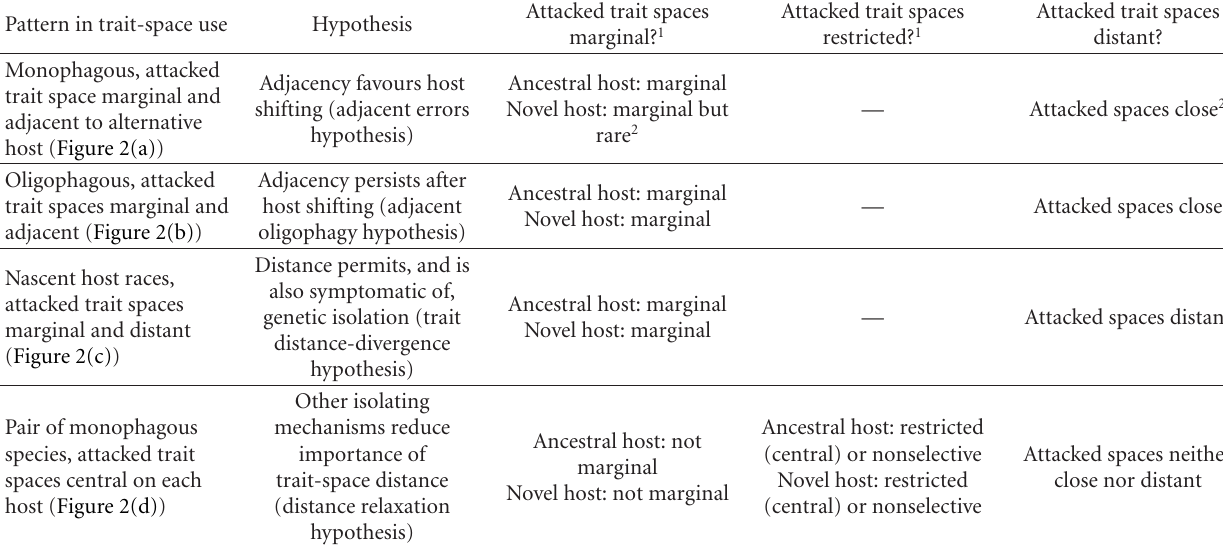
Table 1: Relationships between patterns in trait-space use (Figures 2(a)–2(d)), the GAP model, and statistical tests implemented for analysis of attacked trait